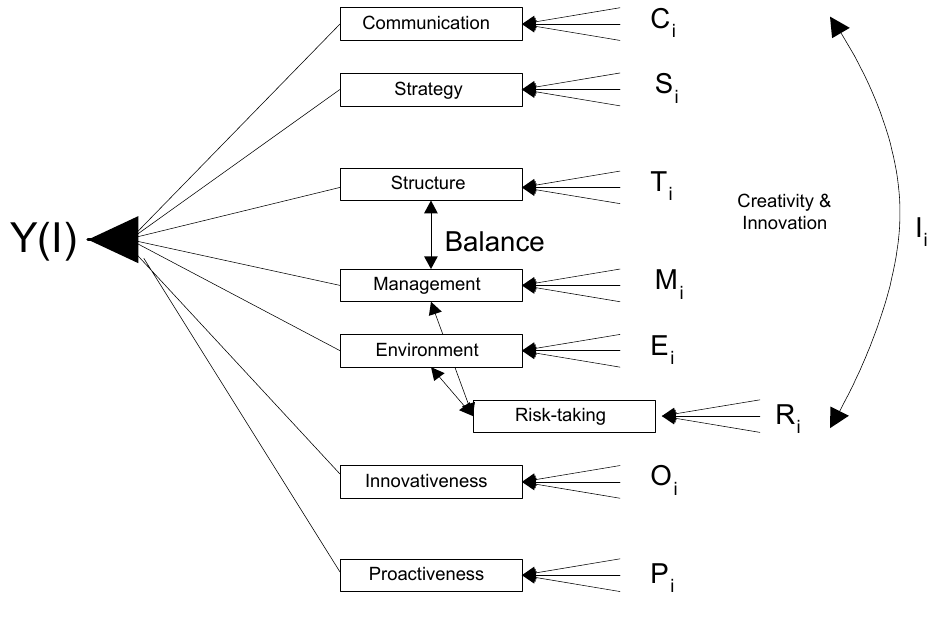
Figure 1: The research relationships The dimensions and their items used in the study are briefly summarised